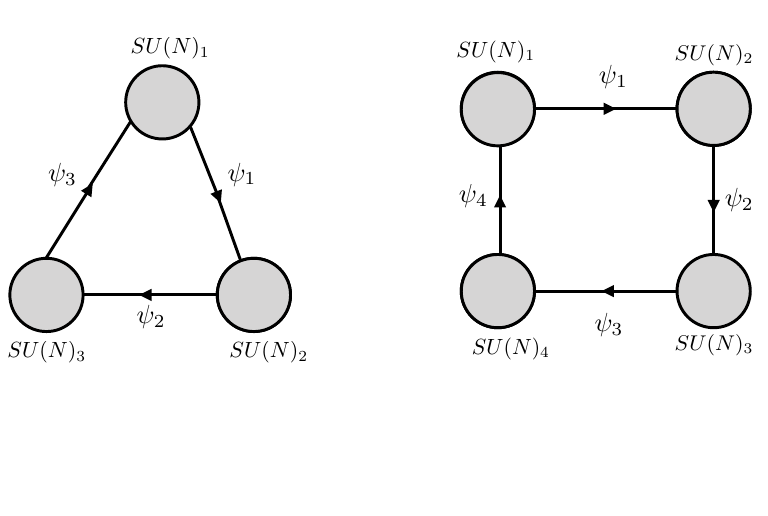
Figure 1 . Simplest examples of chiral quiver theories with odd ( K = 3) and even ( K = 4) number of sites. The symmetries, symmetry realizations and anomalies of the K odd quiver theories are same as vector-like N = 1 SYM, and the one of the K even theories are same as vector-like QCD with bi-fundamental fermions. K even theories have irremovable (cid:18) angle despite the existence of massless fermions, which alters the dynamics